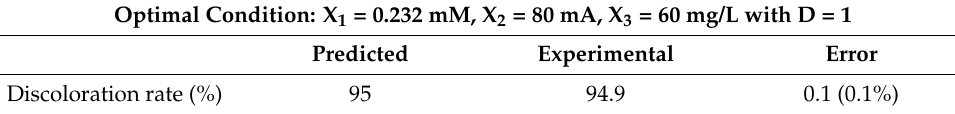
Table 2. Verification experiments under optimal